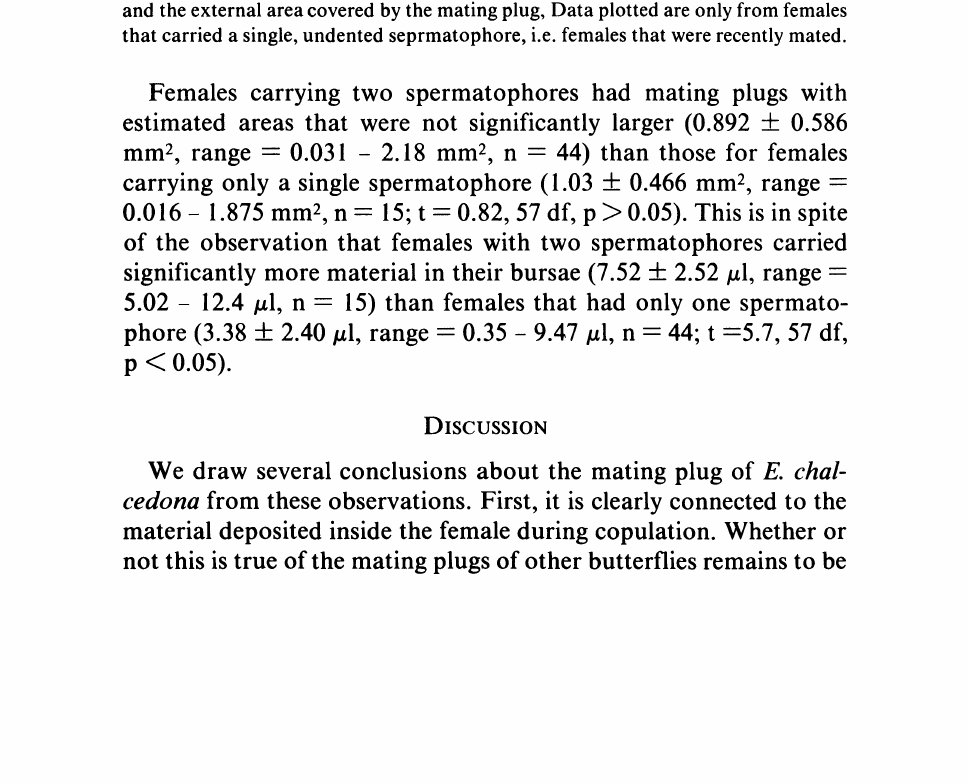
Figure 2. The relationship between the quantity of material received by a female and the external area covered by the mating plug, Data plotted are only from females that carried a single, undented seprmatophore, i.e. females that were recently